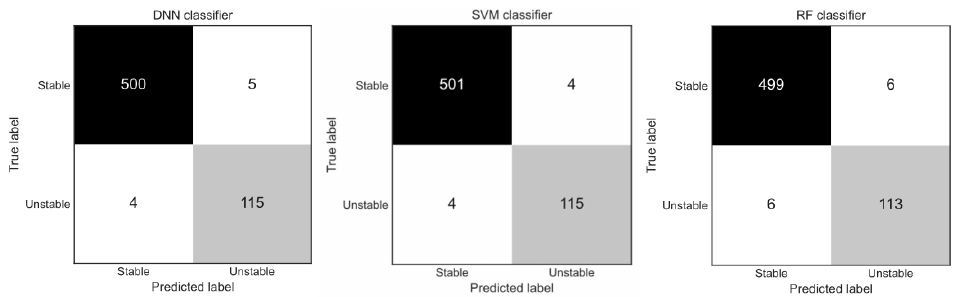
Figure 11. A confusion matrix for the DNN, SVM, and RF classifiers, determined on the test